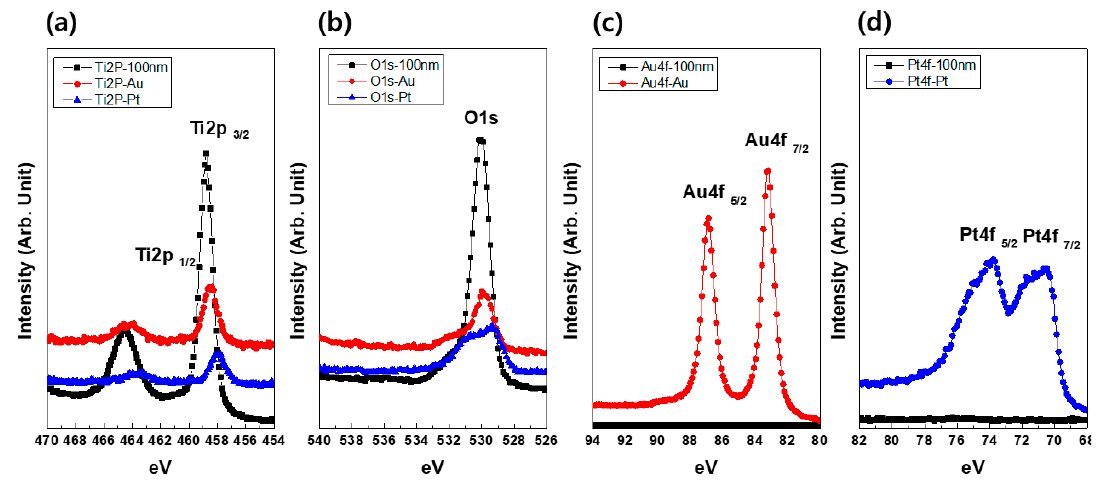
Figure 4. X-Ray Photoelectron Spectroscopy (XPS) spectra of ( a ) Ti2p, ( b ) O1s, ( c ) Au4f, and ( d ) Pt4f in Au–TiO 2 NTs (1 min of Au coating) and Pt–TiO 2 NTs (2 min of Pt coating).